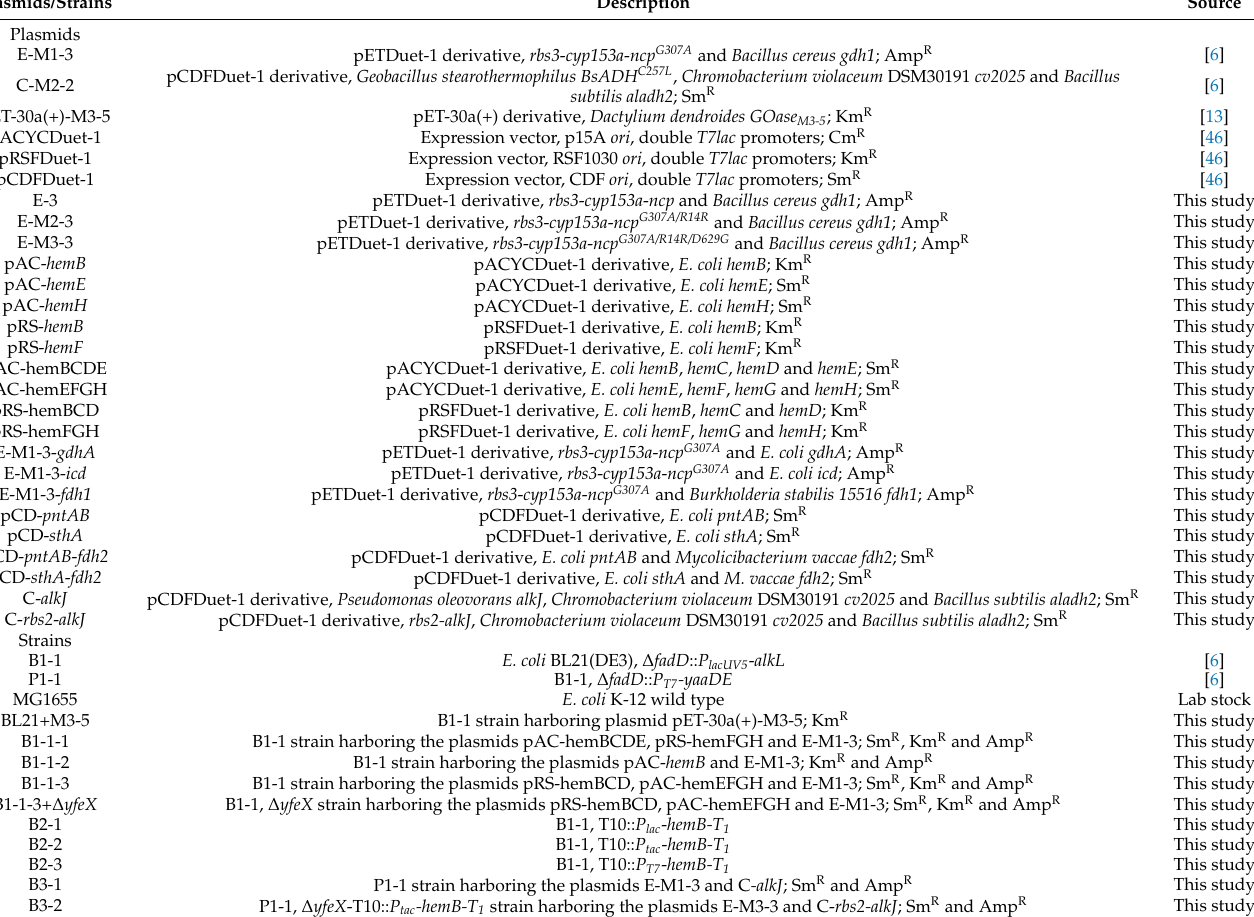
Table 4. Plasmids and strains used in this